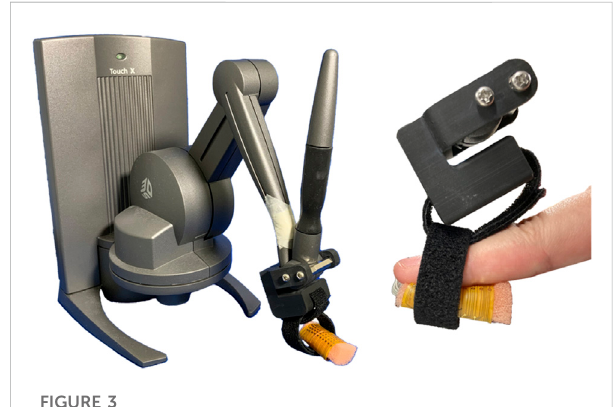
FIGURE 3 force and cutaneous sensations presentation